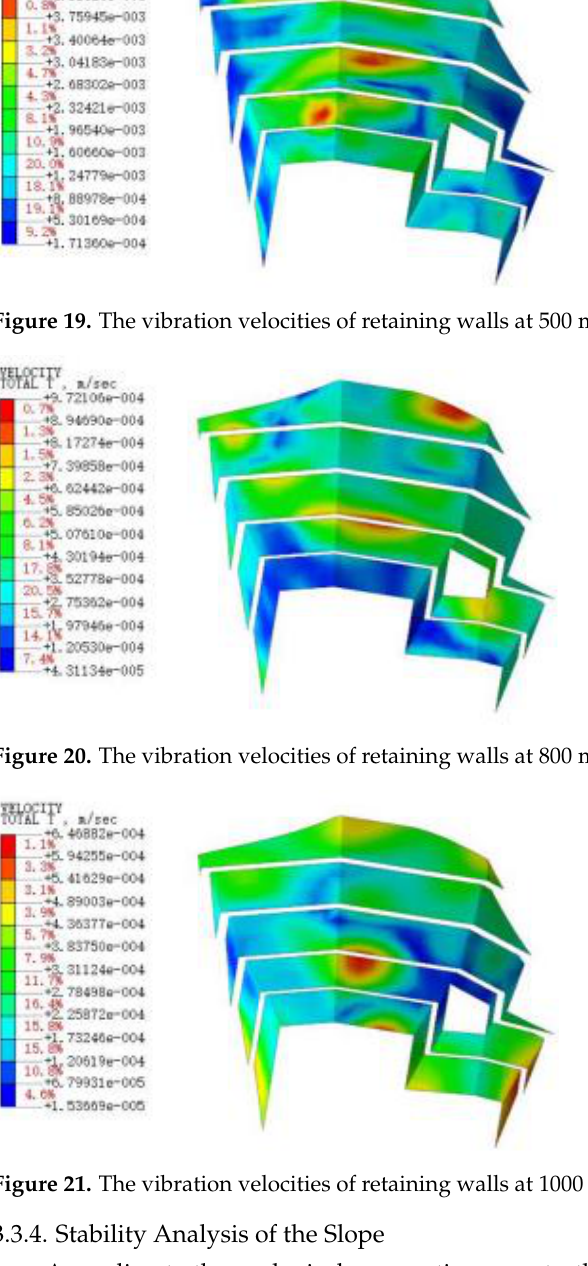
Figure 21. The vibration velocities of retaining walls at 1000 ms.